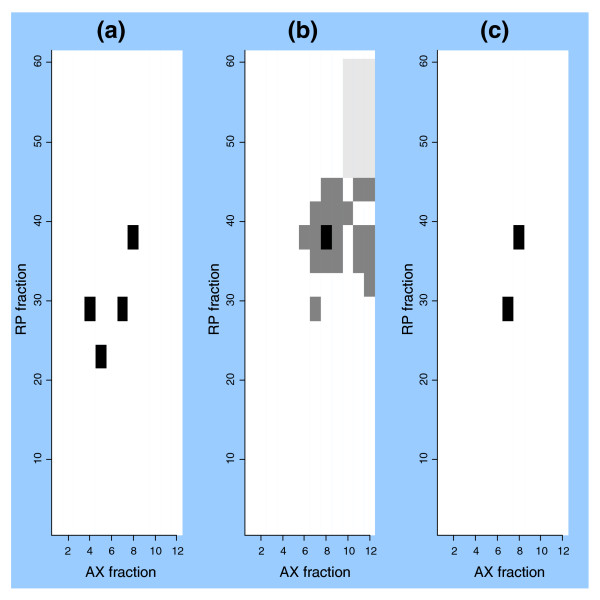
IPAS mapping of splice isoform variants for the MHC H2 K1 K gene. Intact proteins were subjected to anion exchange (AX) and reverse phase (RP) chromatography fractionation. Each fraction was then subjected to tryptic digestion and LC-MS/MS analysis. Peptides derived from novel exons falling within the MHC 2 K1 K gene were identified. Spectral counts for matching peptides derived from this gene are plotted as a function of AX and RP fractionation. The color of each cell indicates the number of matching spectra: black = high; gray = medium; light gray = low; white = zero. (a) The distribution of spectra matching the major annotated splice isoform (ENSMUST00000025181). (b) The distribution of spectra matching the novel splice isoform (M17C4317_13_s2_e917_1_rf2_c1_n0|). (c) The distribution of spectra matching peptides found in both the major annotated splice isoform for this gene (ENSMUST00000025181) and the novel splice isoform (M17C4317_13_s2_e917_1_rf2_c1_n0|).